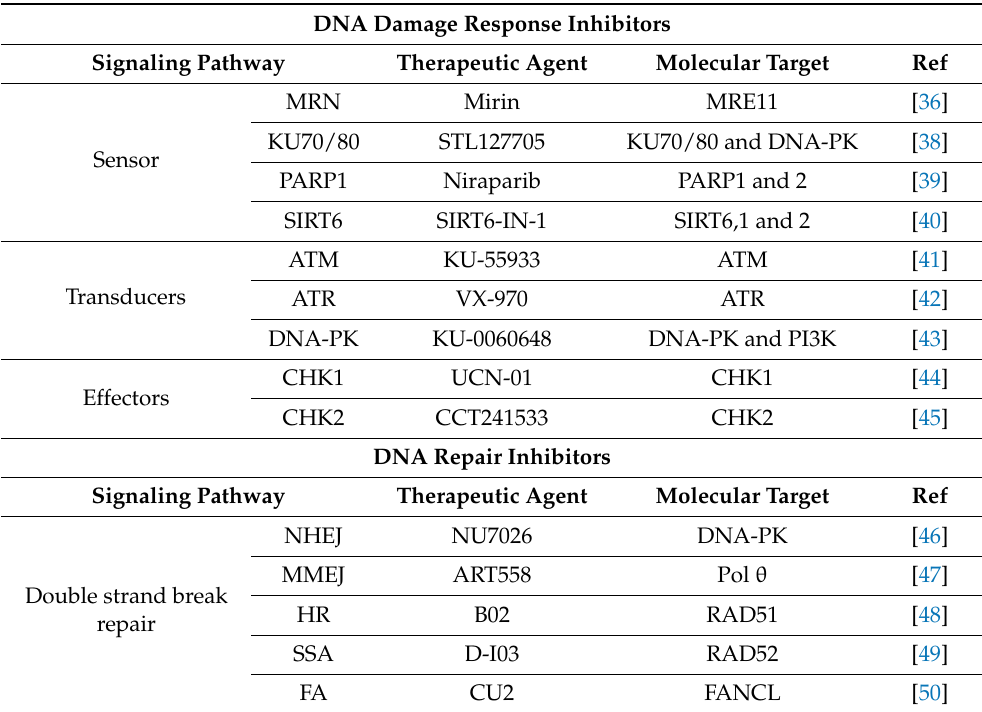
Table 1. Current available inhibitors of DNA damage response and DNA repair